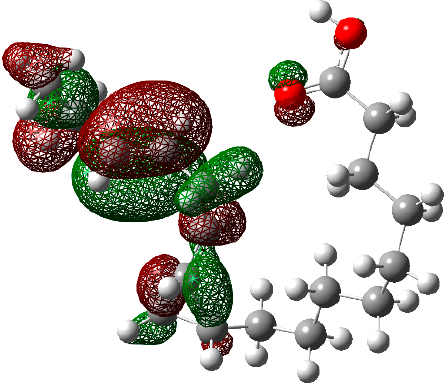
Figure 13. The highest occupied molecular orbital (HOMO) for the protonated α -linoleic acid in the aqueous phase.